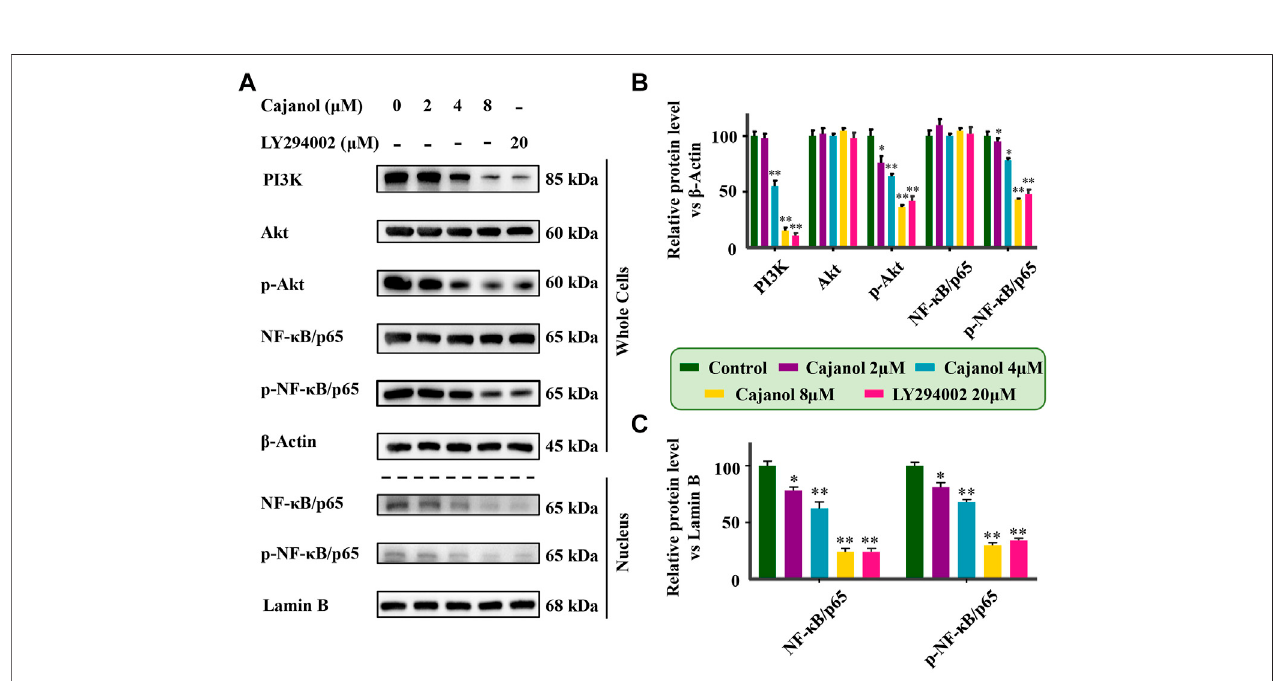
FIGURE 4 | Inhibition of cajanol on PI3K/Akt/NF- κ B pathway in A2780/Taxol cells. (A) Expression of PI3k, Akt, P-Akt, NF- κ B/p65 (whole cells and nucleus) and p-F- κ B/p65 (whole cells and nucleus) in A2780/Taxol cells after treatment with cajanol and LY294002. (B,C) Expression was normalized with ß -actin or lamin B, respectively. Each column shows the mean ± S.D. * p < 0.05, ** p < 0.01 vs . control group.